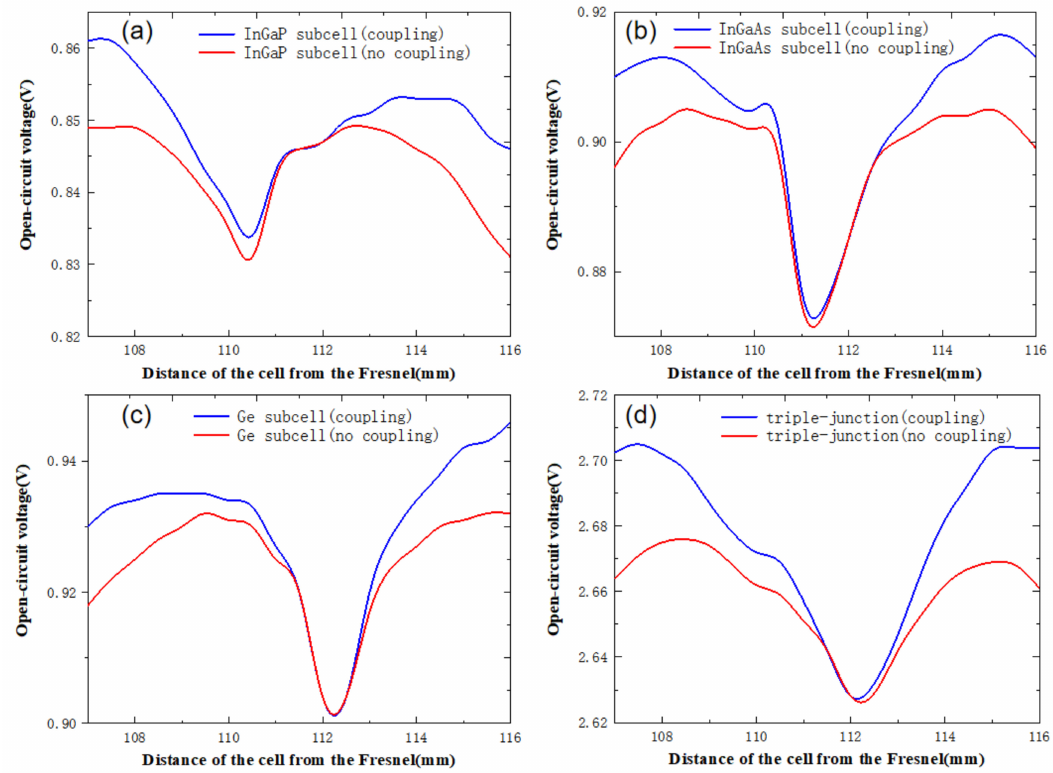
Figure 11. Open-circuit voltage at different optical axis positions. ( a ) InGaP sub cell; ( b ) InGaAs sub cell; ( c ) Ge sub cell; ( d ) Triple-junction solar